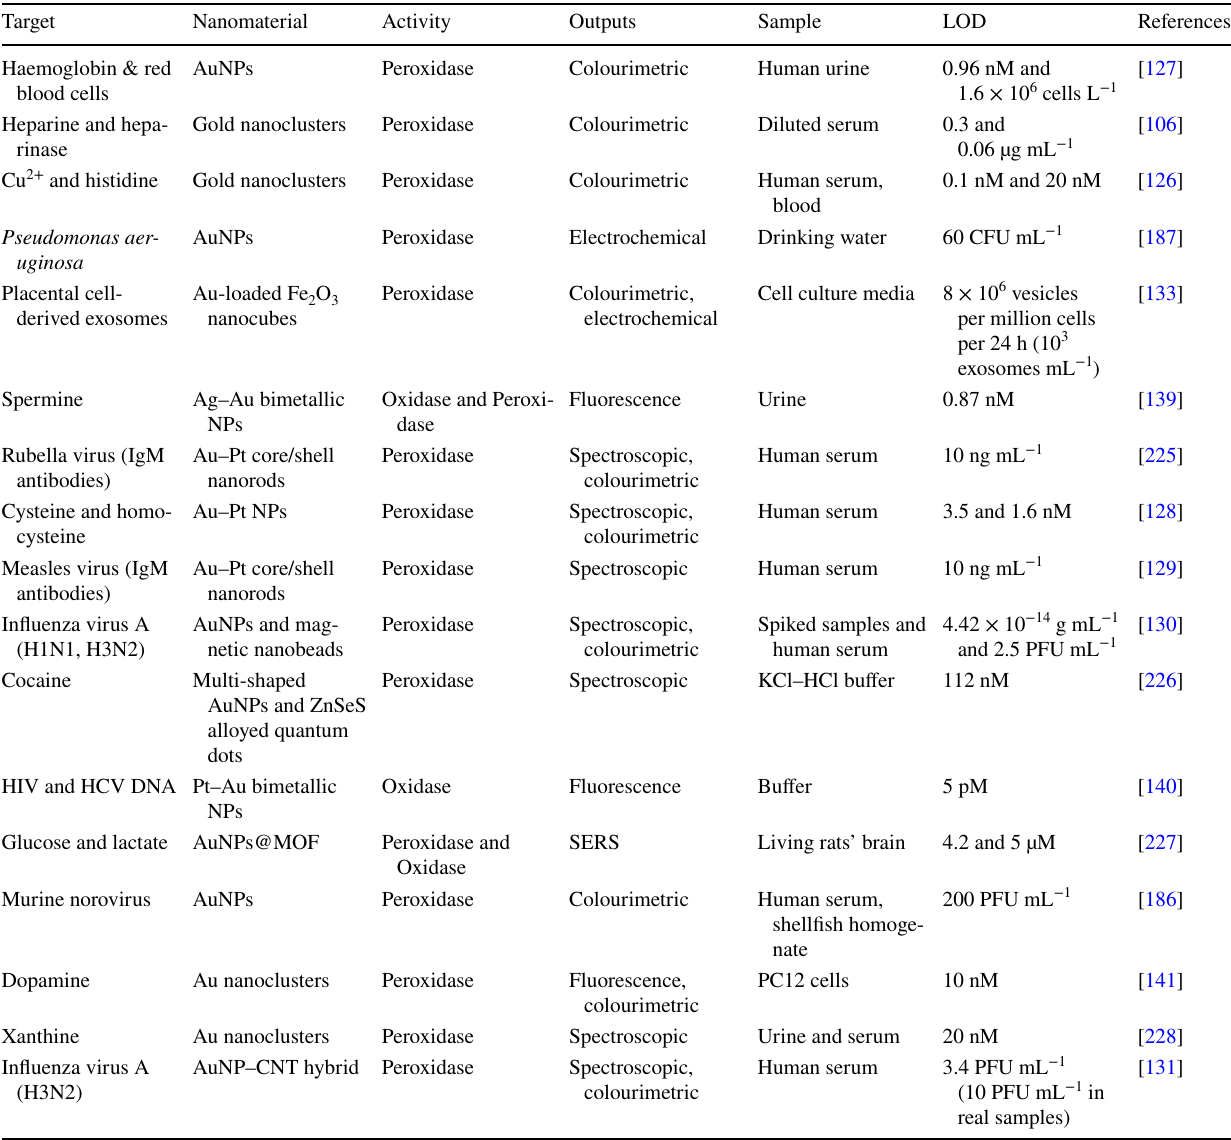
Table 1 Clinical biosensors relate the use of the catalytic properties of gold nanomaterials